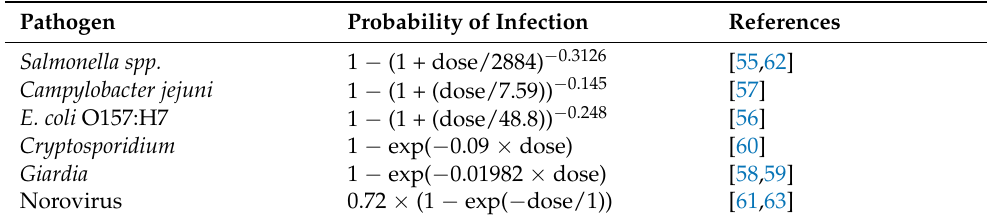
Table 2. Dose–response models utilized to estimate probability of infection in the